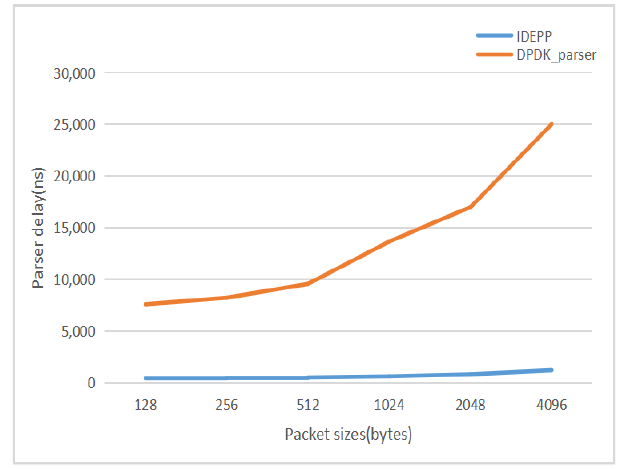
Figure 10. Parsing latency variation.